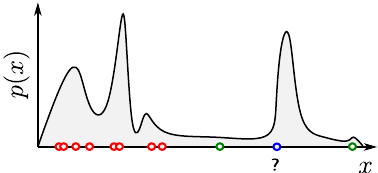
FIG. 1. A central problem in machine learning is how to find a model that performs well with regard to a distribution p ( x ) over data points x if only a small set of samples from that distribution is given. In supervised learning, the data samples are labeled (red and green dots) and the goal is to label a new sample (blue dot). Especially in high dimensions, the samples will not be able to provide information on the entire data space (here, indicated by the region of high density with no samples). Learning is only pos- contains a lot of structure, which is not always easy to analyze